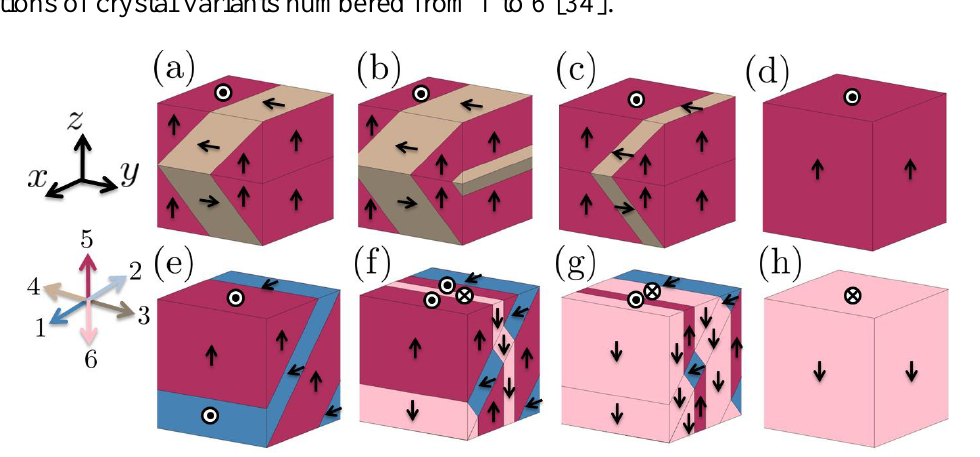
crystal subjected to a cyclic 3